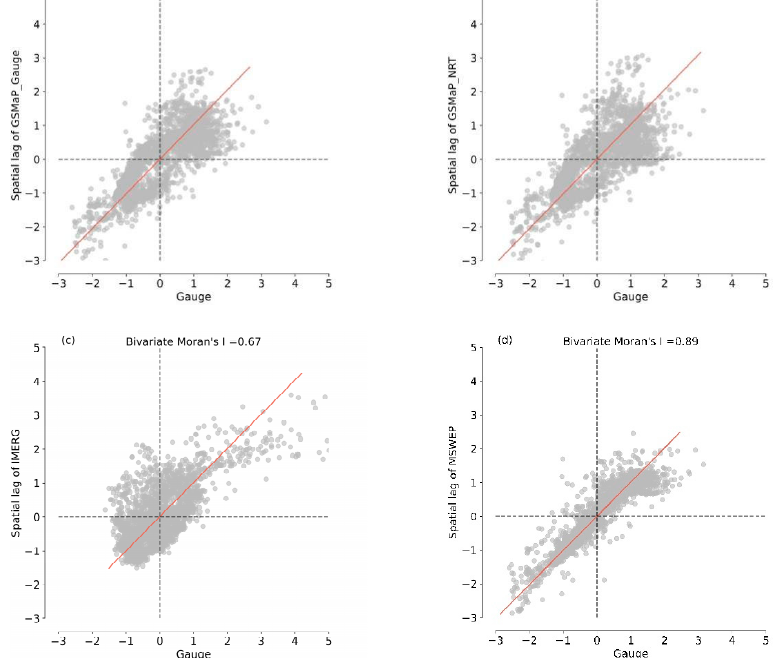
Figure 3. The global BMI sca tt er plot of ATD between the gauge observations and the four SPPs: ( a ) GSMaP_Gauge, ( b ) GSMaP_NRT, ( c ) IMERG, and ( d ) MSWEP. The LISA cluster maps of ATP and ATD are presented in Figures 4 and 5. Figure 4 indicates that the ATP produced by GSMaP_Gauge, IMERG, MSWEP, and the gauge ob- servations demonstrate a strong positive spatial correlation with L-L clusters in NWC, NC and TP, and H-H clusters in central and southern SC. Meanwhile, there is a notable nega- tive spatial correlation between the gauge observations and GSMaP_NRT in the TP, which is evidenced by the L-H clusters in the eastern region of the plateau, suggesting that GSMaP_NRT signi fi cantly overestimates ATP.